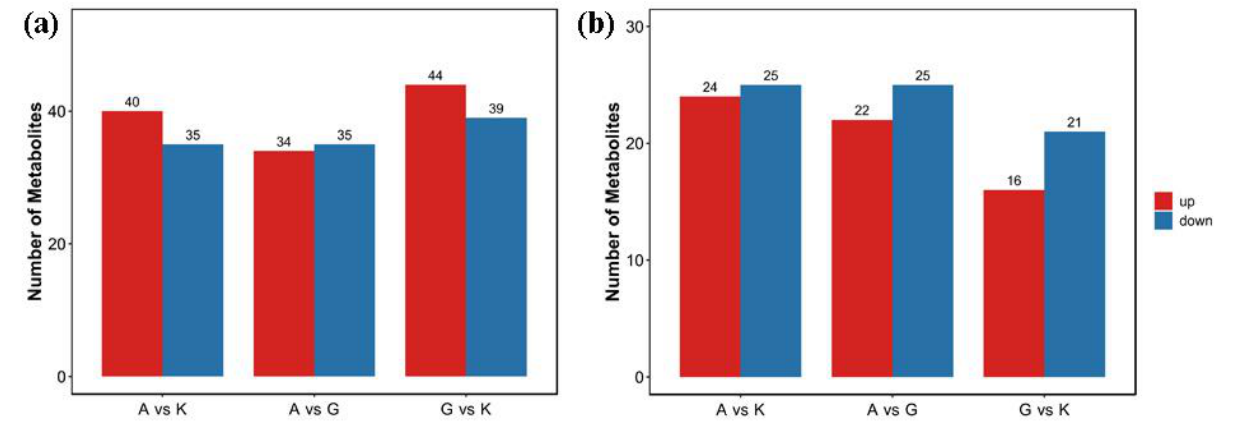
Figure 4. Differential metabolites between groups. ( a ) DiffExp metabolites statistics of POS ions; ( b ) DiffExp metabolites statistics of NEG ions.